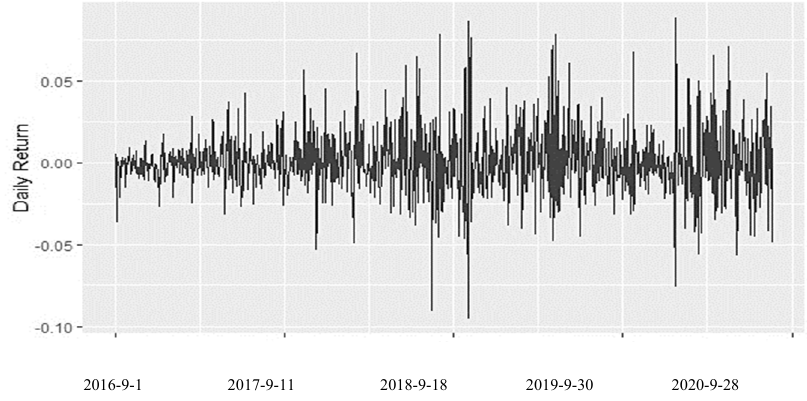
Figure 1. Distribution of Log Returns in the Airport Shipping Set (31 August 2016–1 September 2020).